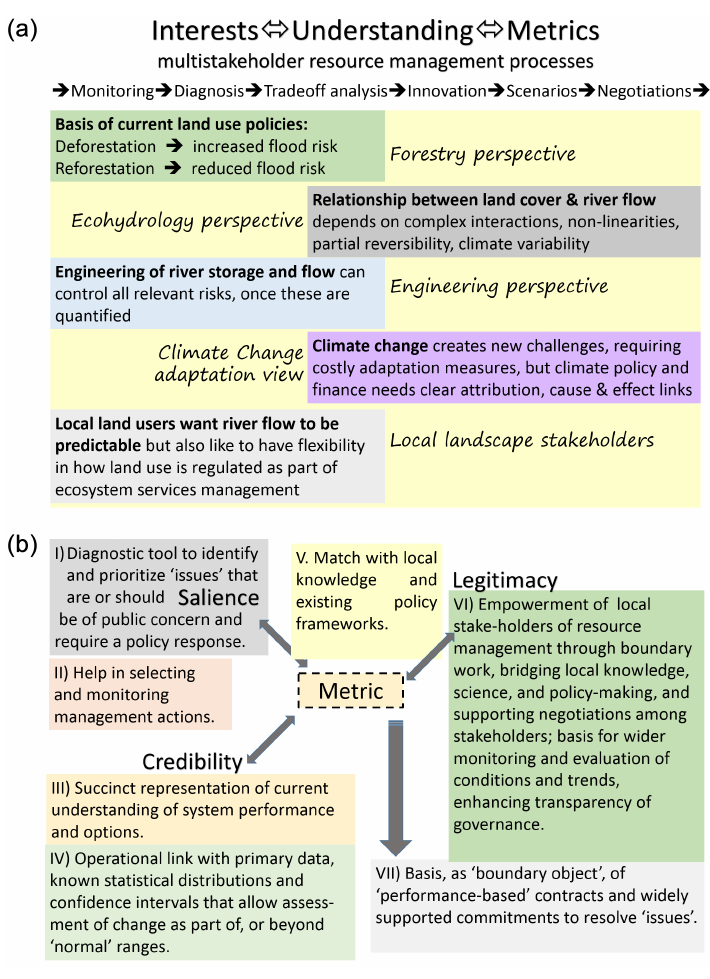
Figure 1. (a) Multiple perspectives on the way flood risk is to be understood, monitored and handled according to different knowledge systems; (b) basic requirements for a “metric” to be used in public discussions of natural resource management issues that deserve to be resolved and acted upon (modified from van Noordwijk et al.,